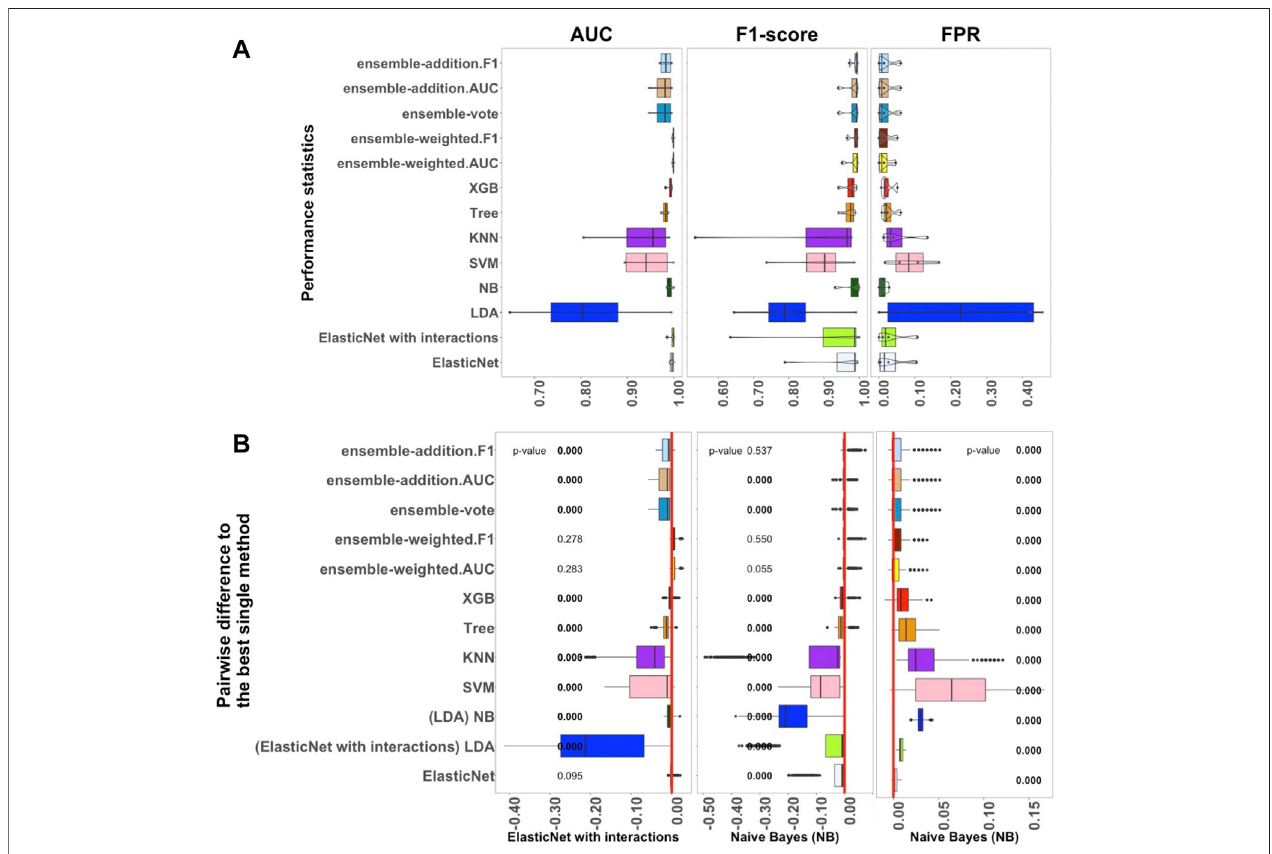
FIGURE2| Performanceof13algorithmswiththefourmedium-sizeddatasets.Thevaluesofthreecriteria(AUC, F1-score,andFPRfromlefttoright)areshownin (A) .Thereare400pointsineachbox.Thevaluesofthesethreecriteriawereusedtorepresenttheperformanceofthecorrespondingalgorithm. (B) Differencesbetween the best single algorithm and the other algorithms. From left to right, the results show the differences in AUC, F1, and FPR including the p -values from the Wilcoxon test; p -values < 0 . 05 are indicated in bold, and the red lines indicate the zero value. The best single methods, of which there were two, are shown at the bottom of the